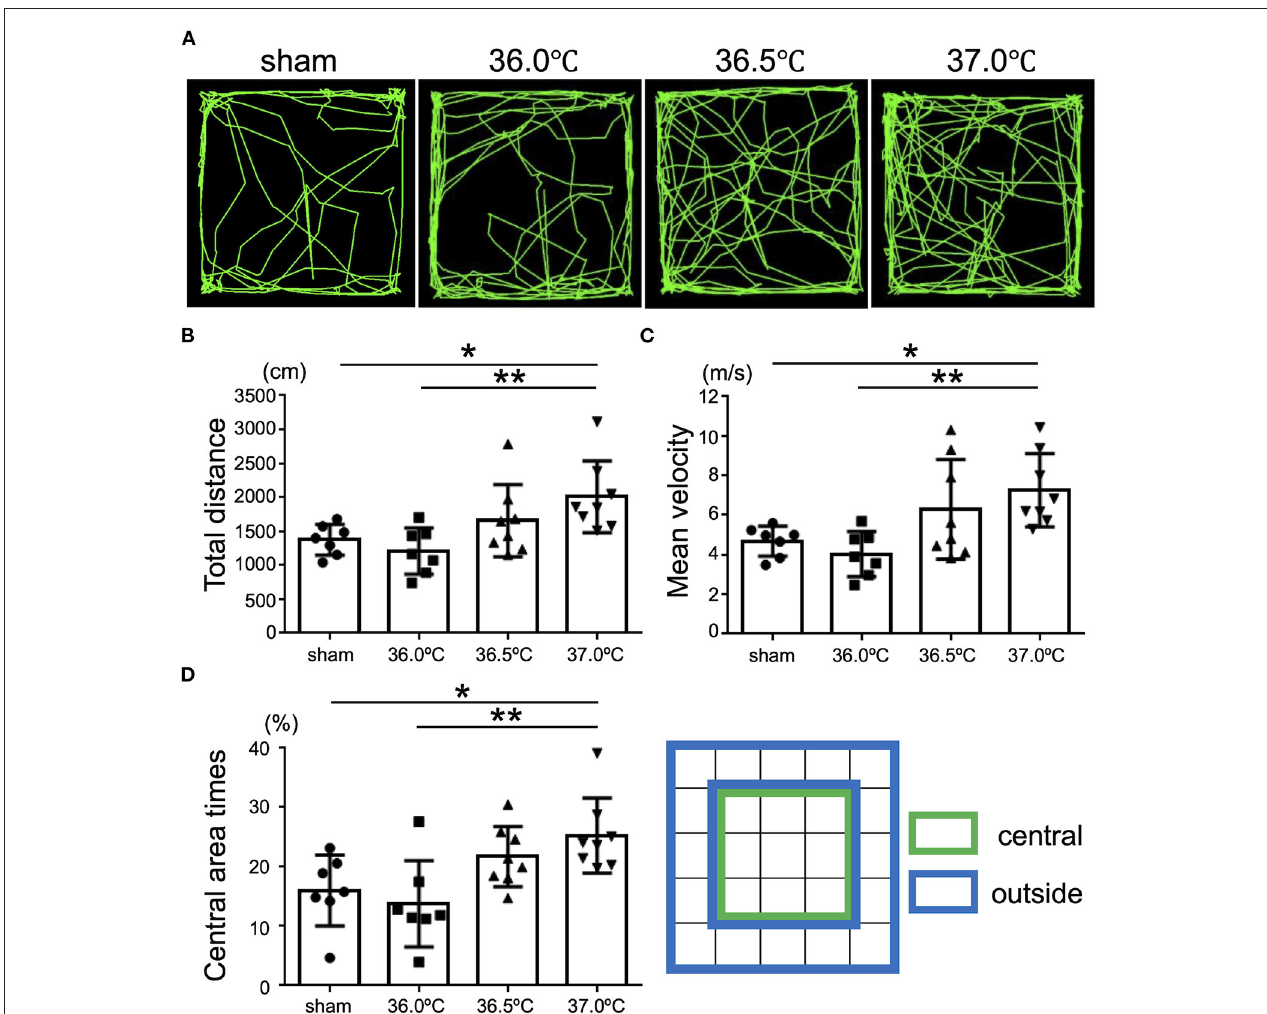
FIGURE 6 | Differences in emotional behavioral dysfunction due to ambient temperature in HIE mice. Open-field tests were performed for evaluation of emotional behavior 2 weeks after hypoxia at temperatures of 36.0 ◦ C, 36.5 ◦ C, or 37.0 ◦ C. (A) The representative behavioral trajectory (green line) for 5min in each temperature group. (B) Total distance of walking for 5min in each temperature group (sham, •, n = 7; 36.0 ◦ C, (cid:4) , n = 7; 36.5 ◦ C, N , n = 8; 37.0 ◦ C, H , n = 8). (C) Mean speed while walking for 5min in each temperature group (sham, •, n = 7; 36.0 ◦ C, (cid:4) , n = 7; 36.5 ◦ C, N , n = 8; 37.0 ◦ C, H , n = 8). (D) The percentage of the time staying in the central area (green) against the outside area (blue) in each temperature group (sham, •, n = 7; 36.0 ◦ C, (cid:4) , n = 7; 36.5 ◦ C, N , n = 8; 37.0 ◦ C, H , n = 8). * p < 0.05, ** p < 0.01. Error bars show means +